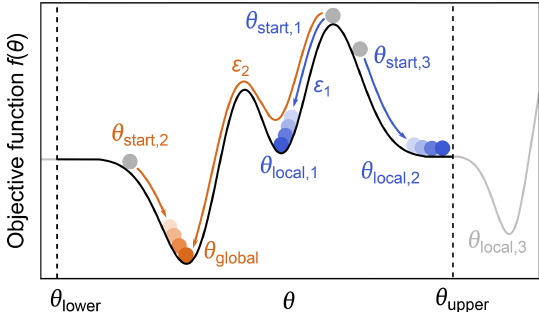
Figure 9. Global vs. local minima. During optimization of a param- eter θ , by minimization of an objective function f ( θ ) (black line), several local minima (blue) might be found instead of the global minimum (orange). The global minimum can be found by varying the starting point, the lower/upper boundaries θ upper and θ lower (to find minima which might be outside the bounds, e.g., θ local , 3 ), or the convergence parameters ε of the numerical solver such that some local minima might be